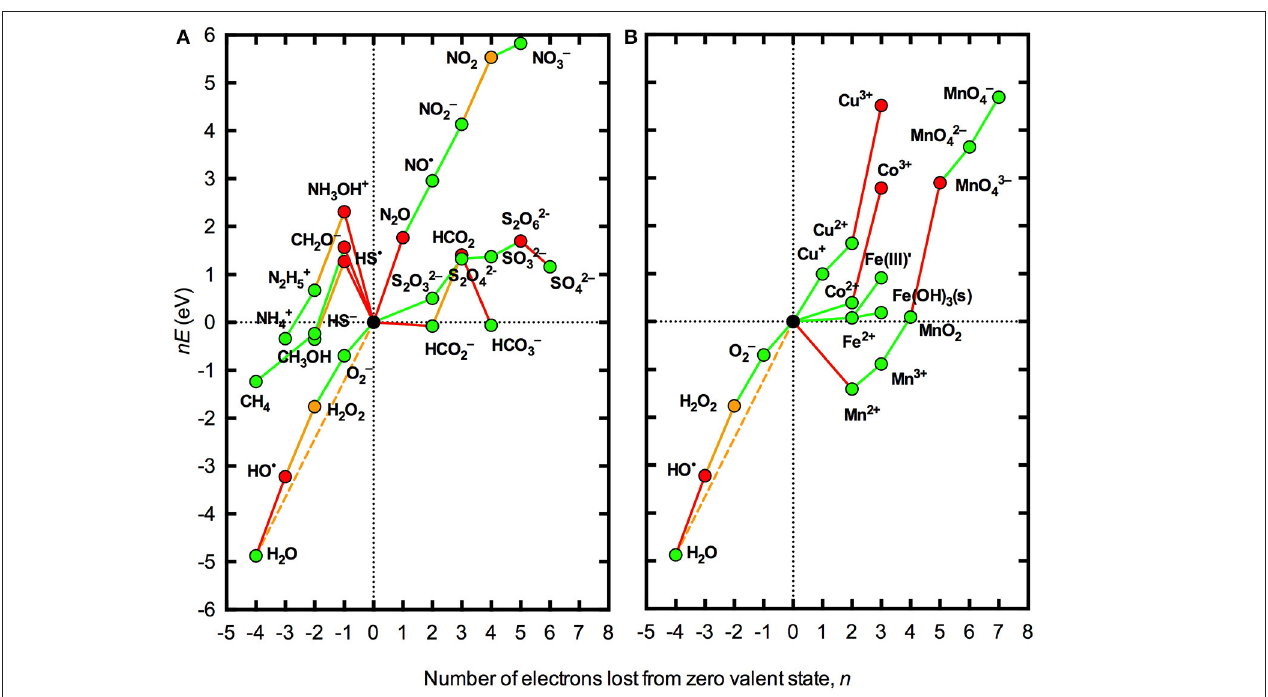
FIGURE 2 | Frost diagrams for some common redox active elements in natural waters at pH 8.1 accounting for typical activities of oxygen redox species in natural waters. (A) Representative species for the major elements C, N, and S. (B) Trace metals Co, Cu, Fe, and Mn. Typical activities were taken as [O 2 ] = 250 µ M, [O − 2 ] = 100 pM ( Rose et al., 2008; Hansard et al., 2010), [H 2 O 2 ] = 100 nM (Yuan and Shiller, 2005; Mostofa and Sakugawa, 2009; Vermilyea et al., 2010; Rusak et al., 2011 ) and [HO • ] = 1 fM (Zhou and Mopper, 1990). These values are based primarily on measurements from seawater, since this is where most measurements of ROS concentrations in natural surface waters have been made. All other conditions and the lines and symbols used are the same as in Figure 1